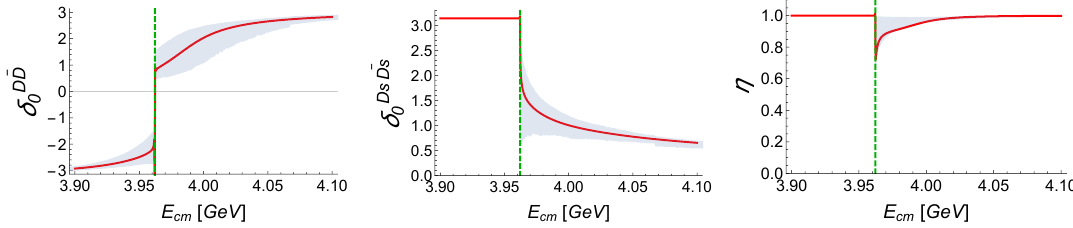
, 0 ’ 1981 MeV. The gray s